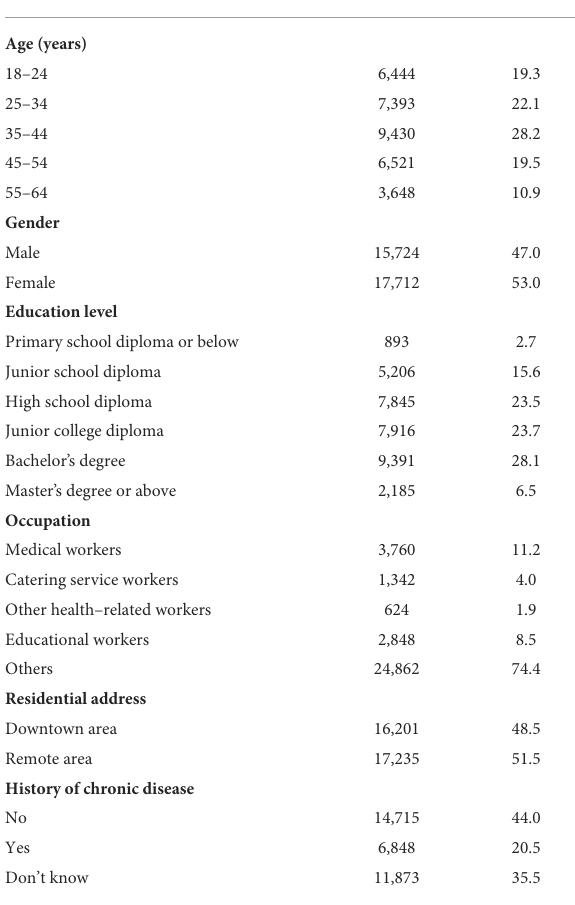
TABLE 1 Sociodemographic characteristics of